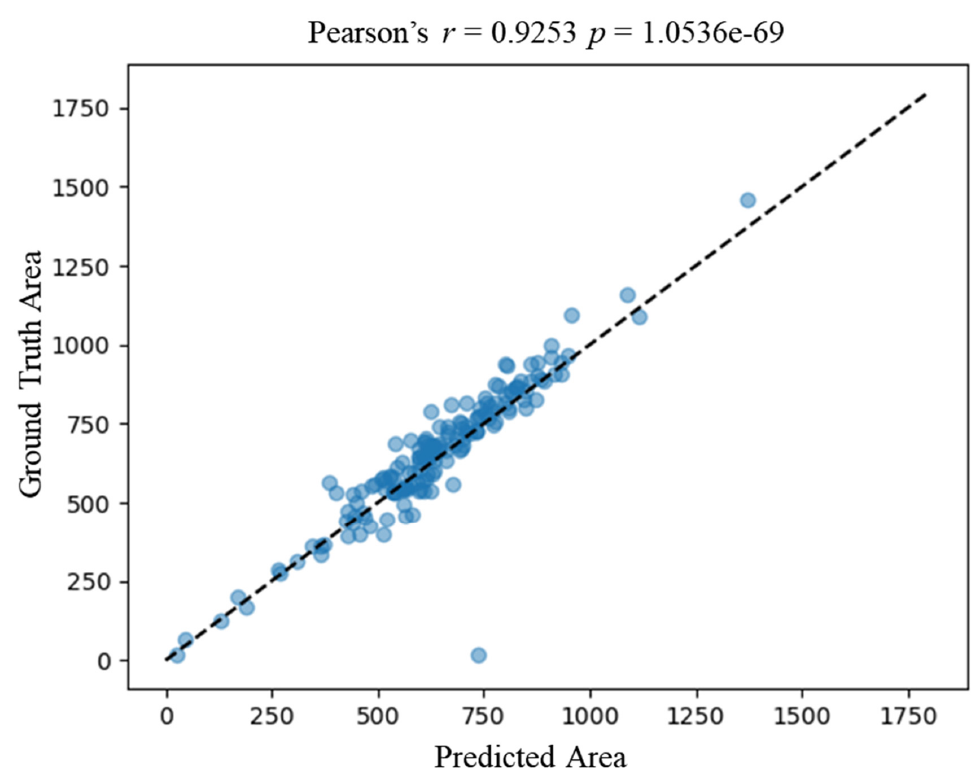
Figure 5. Correlation between predicted area by the proposed framework and the ground truth area. The x -axis represents the predicted area of an image, and the y -axis represents the ground truth area. Each blue dot represents a nucleus. The dashed line represents the ideal correlation. Area_ground_truth = Area_predicted.